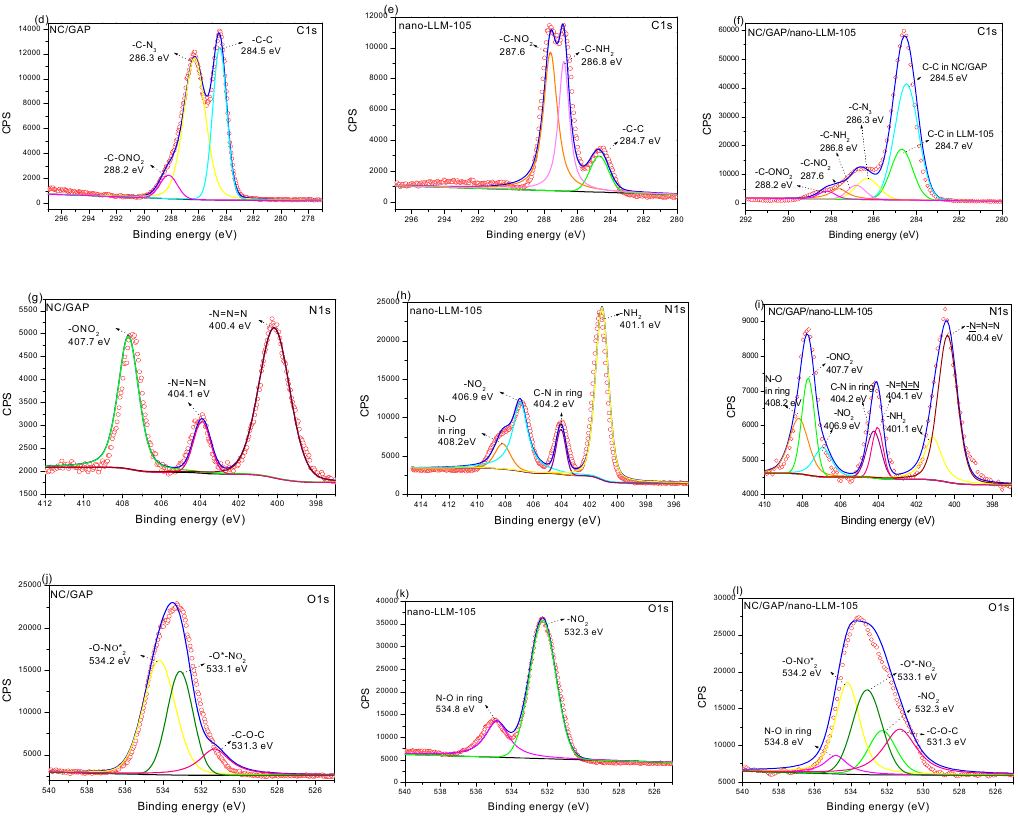
Figure 6. ( a – c ) XPS spectra of NC / GAP, nano-LLM-105 and NC / GAP / nano-LLM-105; high resolution XPS spectra ( d – f ) for C 1s of samples; for ( g – i ) N 1s of samples and for ( j – l ) O 1s of samples.